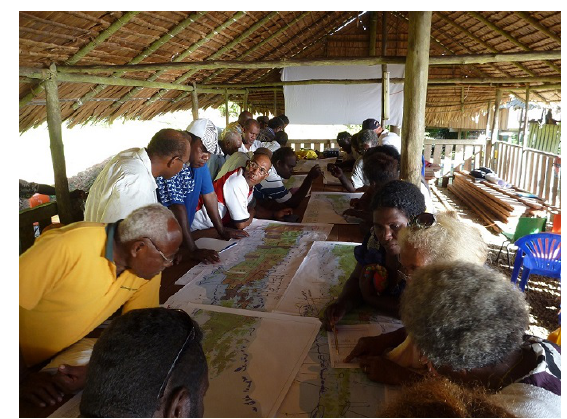
Fig. 3 . Participants in the “Ridges to Reefs” conservation planning workshop, Kia, Santa Isabel, Solomon Islands, March 2012. (Photo: Nate